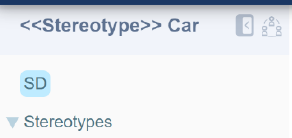
Figure 4. The Save Stereotype menu for OPCloud admins. ( a ) OPCloud main menu OPM Stereotypes options. ( b ) the Save Stereotype screen.